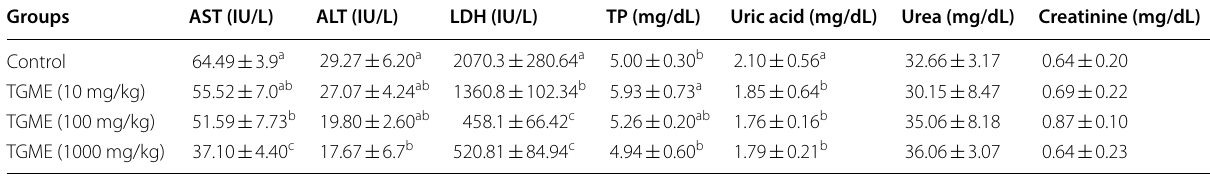
Values are expressed as mean AST aspartate aminotransferase, ALT alanine aminotransferase, LDH lactate dehydrogenase, TP total protein, TGME Triclisia gilletii aqueous methanolic extract